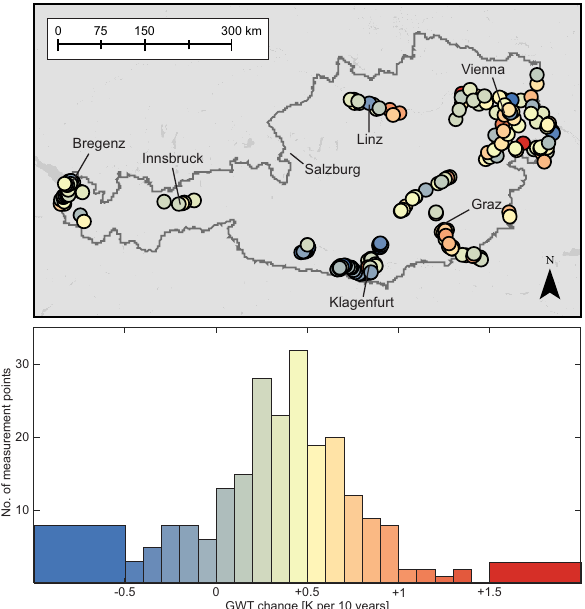
Figure 4. Increase in temperature for all individual measurement points for the 20-year timeframe January 1994 to December 2013. The mean change in groundwater temperature is + 0.4 ± 0.5K per 10